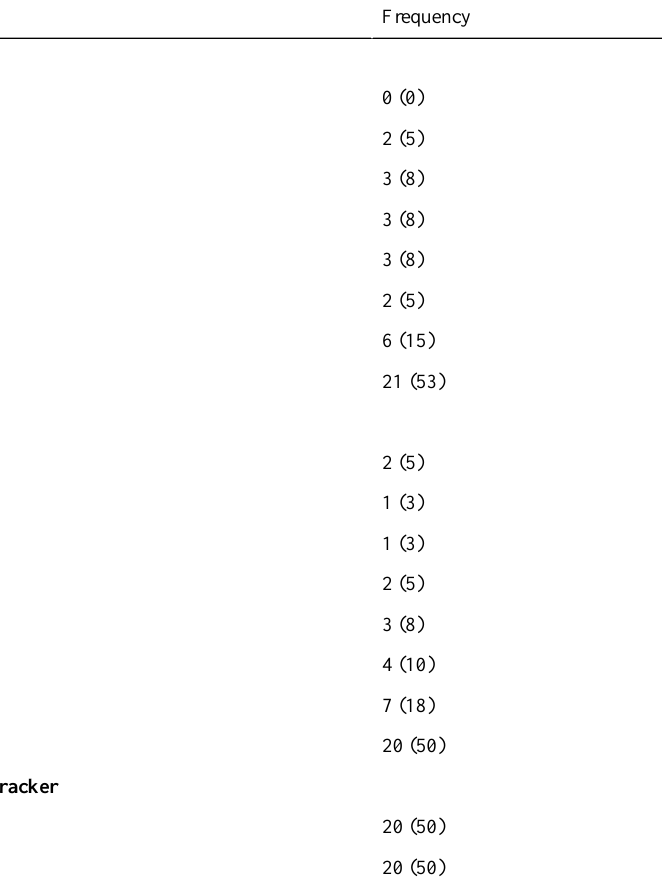
Table 2. Fitbit self-monitoring questionnaires